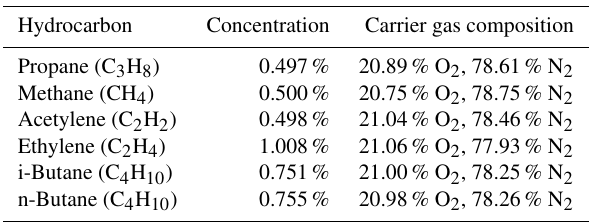
Figure 6. Sensitivity towards oxygen as a function of the sample gas flow for different burning gas flows with illustration of the al- lowed range of the sensitivity towards oxygen for emission moni- toring (dotted lines). Table 1. Sample gases used for determination of the response fac-